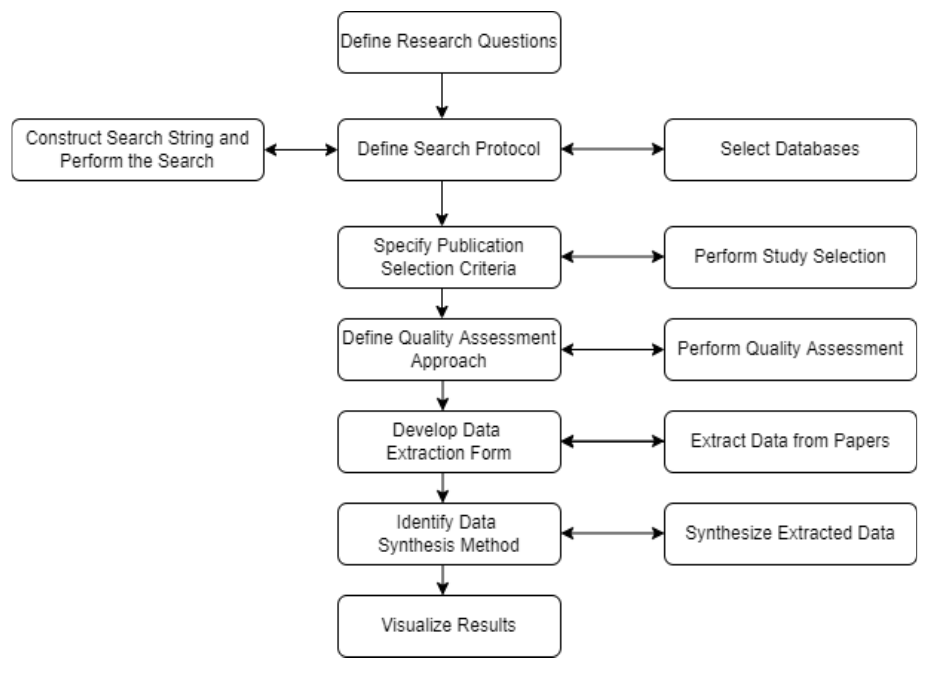
Figure 1. Flowchart of the